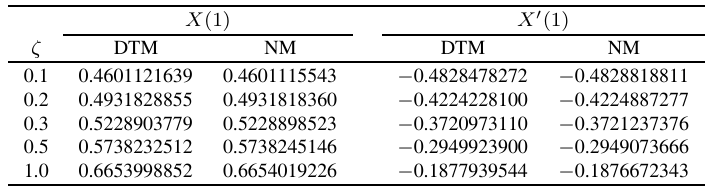
Table 7 The comparison between the Numerical and DTM solution of X (1) and X (cid:3) (1) for